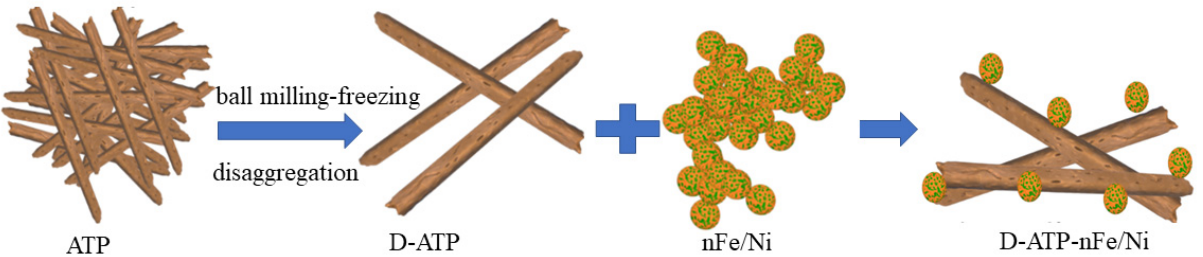
Figure 4. Schematic representation of the disaggregation of ATP by the ball milling–freezing process and dispersion of nFe/Ni by D-ATP as a support.